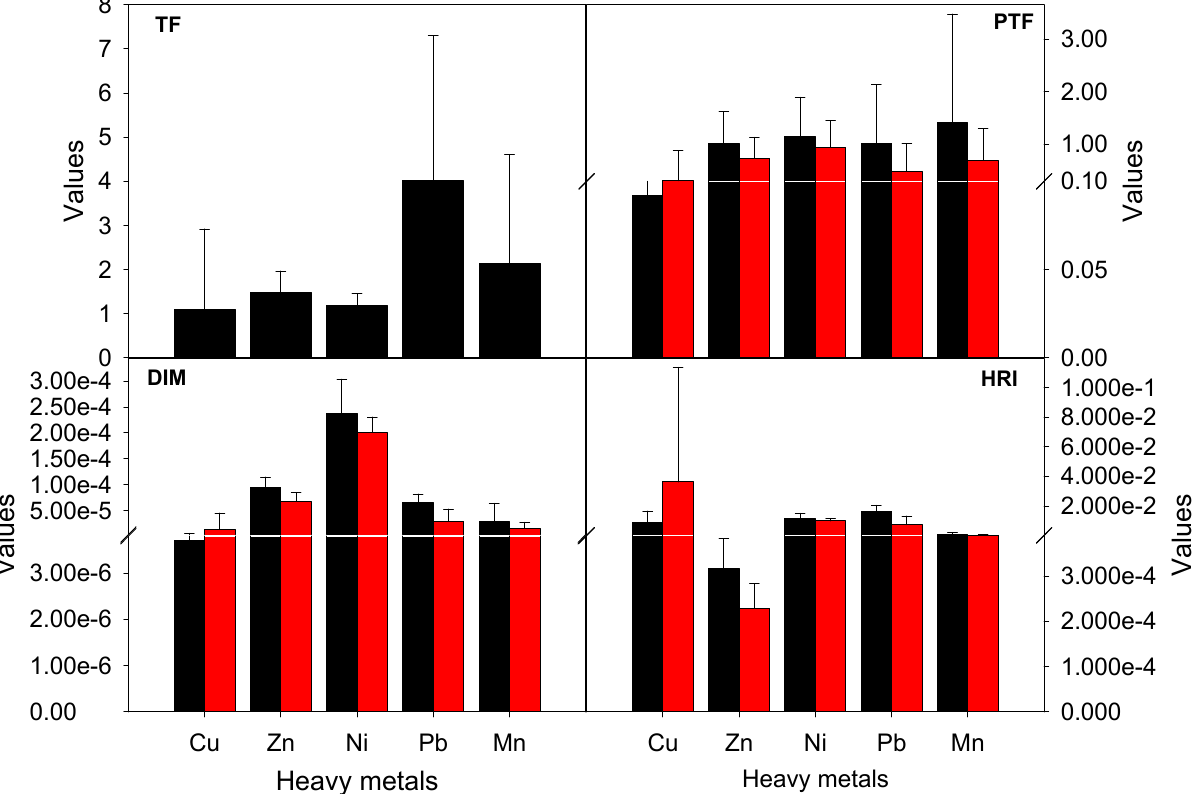
Figure 4. Mean Translocation factor (TF), plant transfer factor (PTF), daily intake of metals (DIM), and health risk index (HRI) values of M. galilaea.